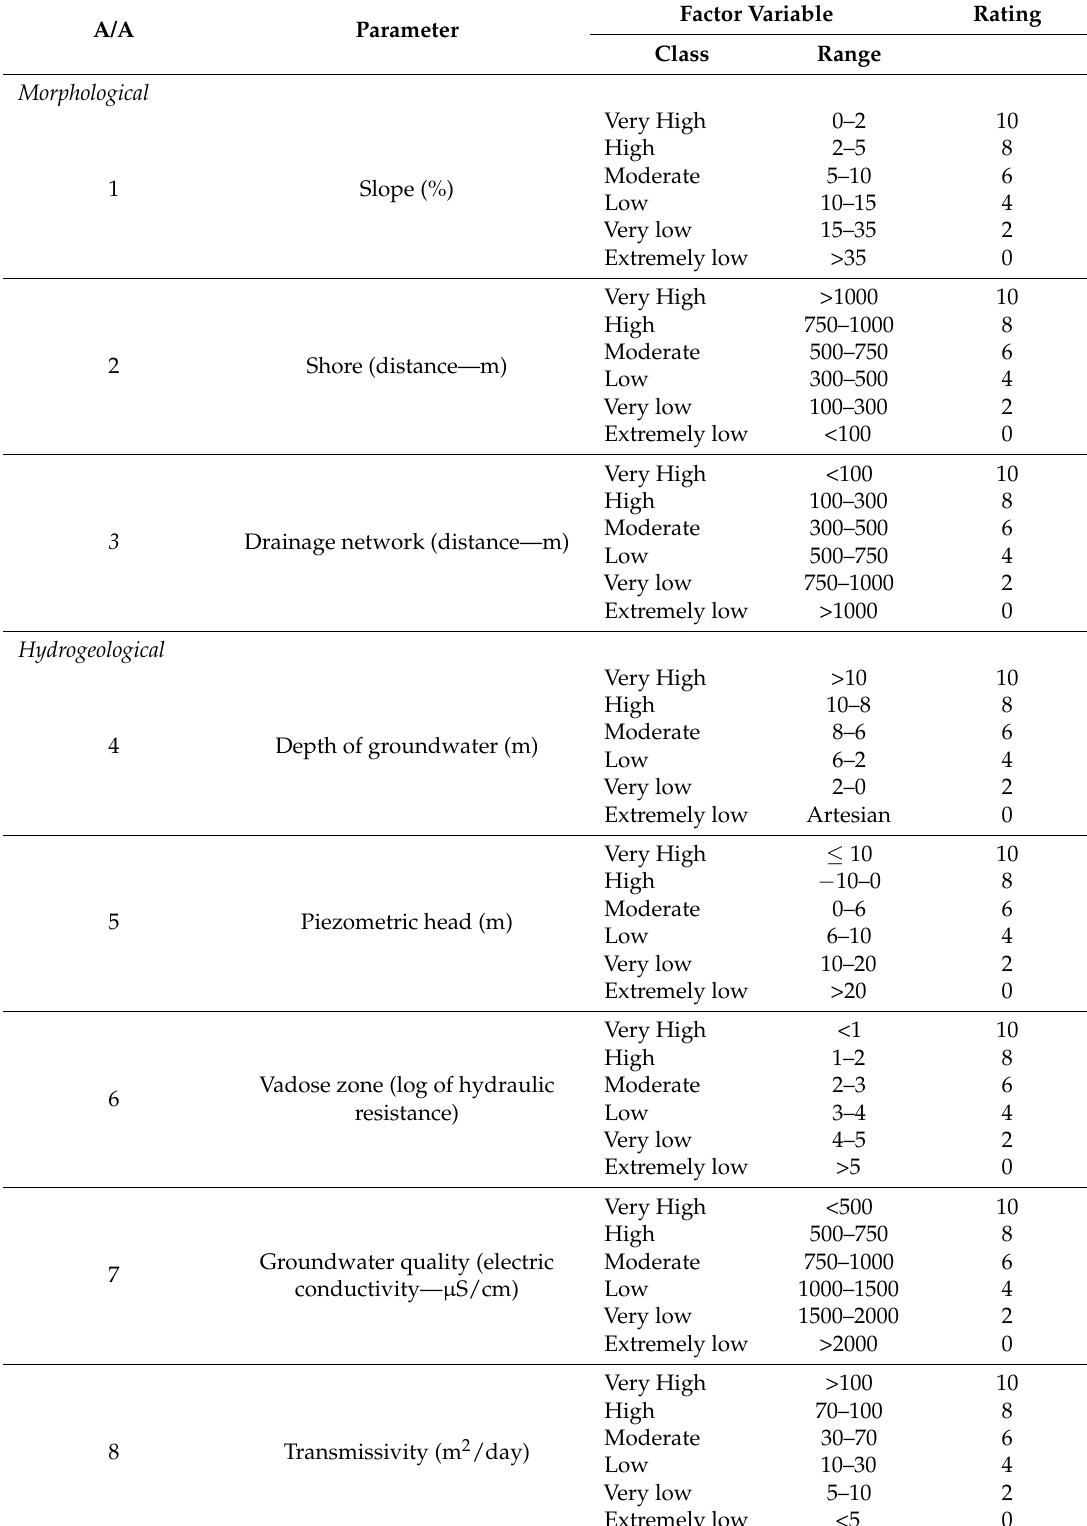
Table 2. Parameters and rating of the MAR suitability